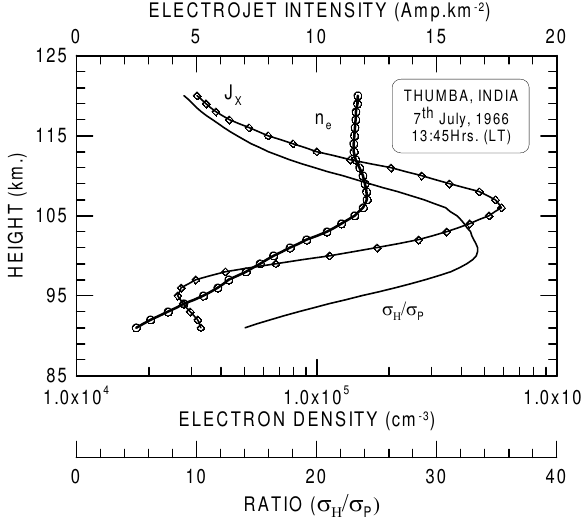
Fig. 1. Height profiles of the electron density and electrojet current intensity estimated from in-situ measurements made from Thumba, India at 13:45 LT on 7 July 1966 (Flight 20.05), compared with the model estimate of the ratio of Hall to Pedersen conductivity profile.